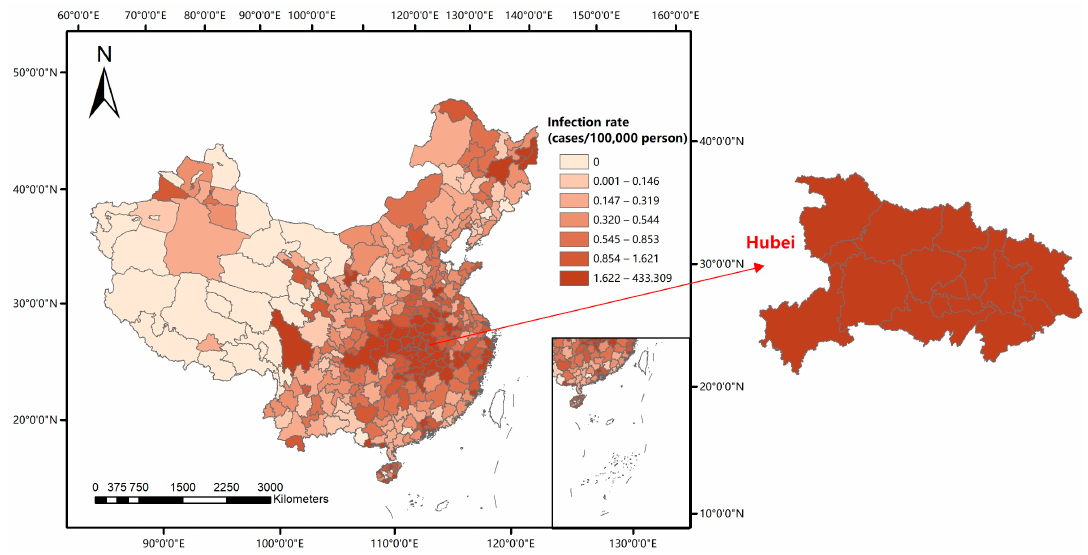
Figure 1. Two study areas (mainland China and Hubei province).